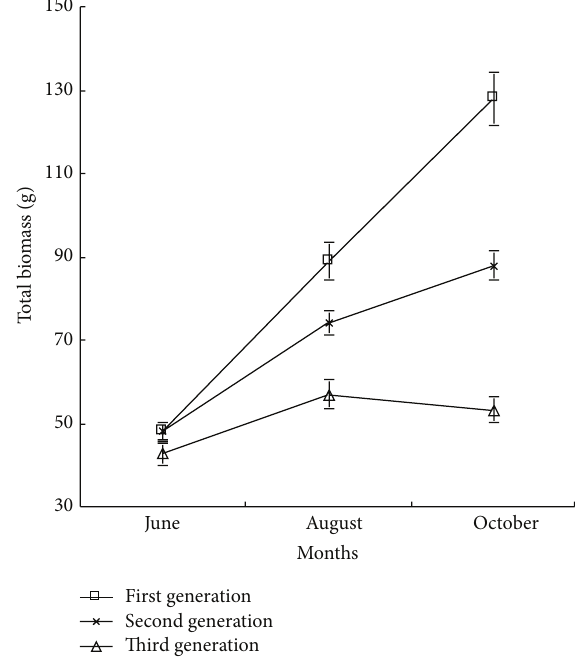
Figure 1: The growth dynamics of total biomass of poplar under different continuous